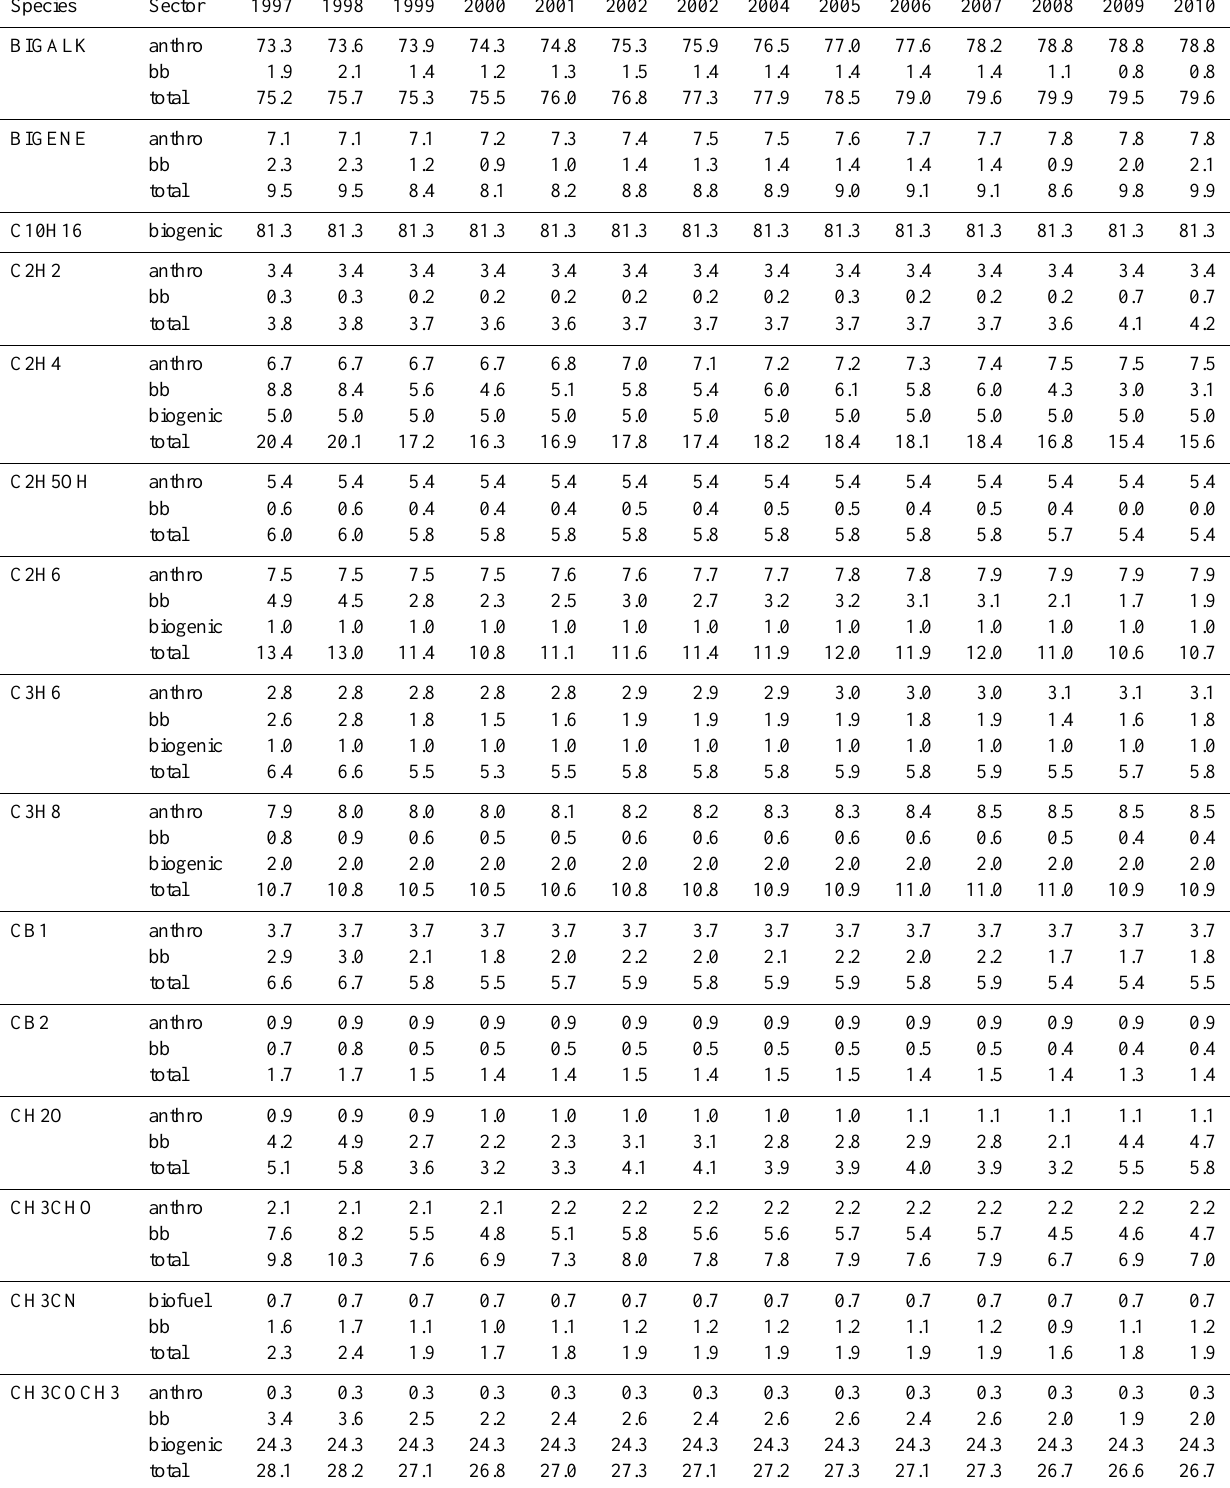
Table 7. Yearly emission totals (Tg(species)yr − 1 ).